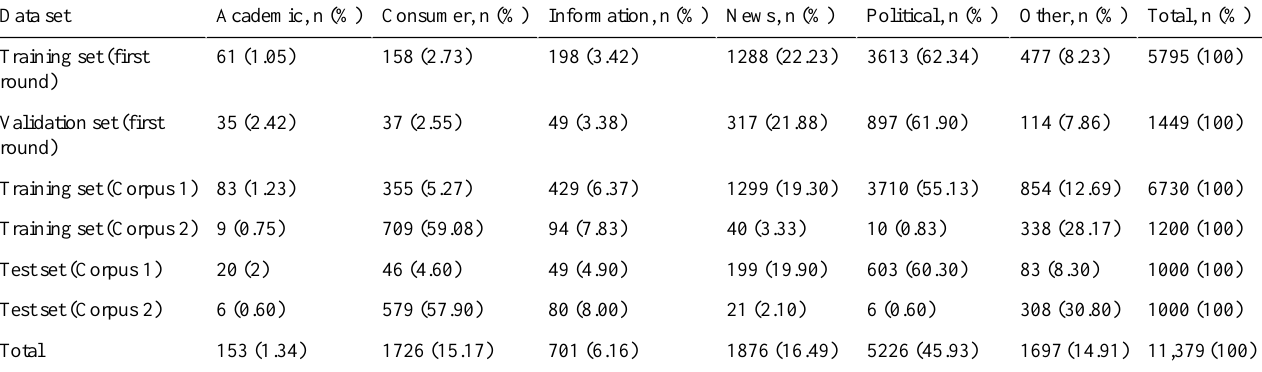
Table 1. Distribution (counts and percentages) of annotated data in the first round of annotations (rows 2 and 3) and the final data sets (Corpus 1 for rows 4 and 6; Corpus 2 for rows 5 and